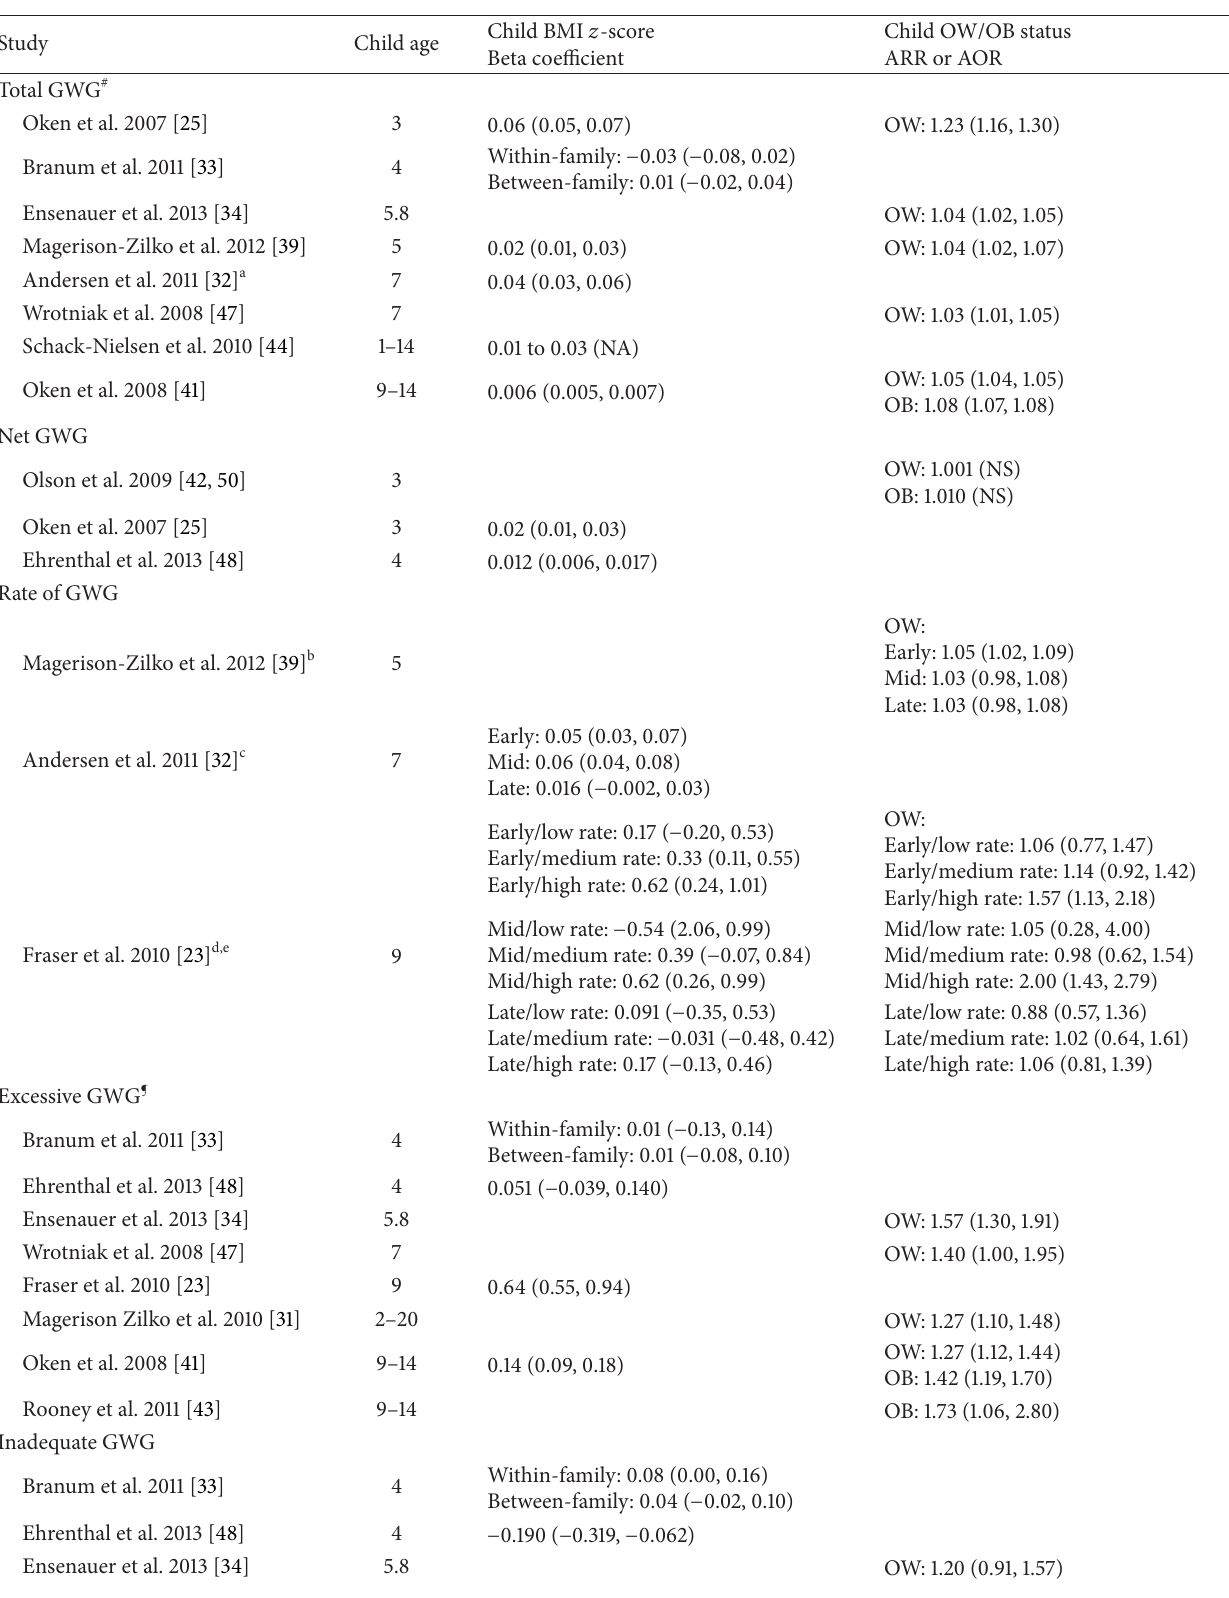
Table 3: Summary of the association between maternal GWG and offspring body weight